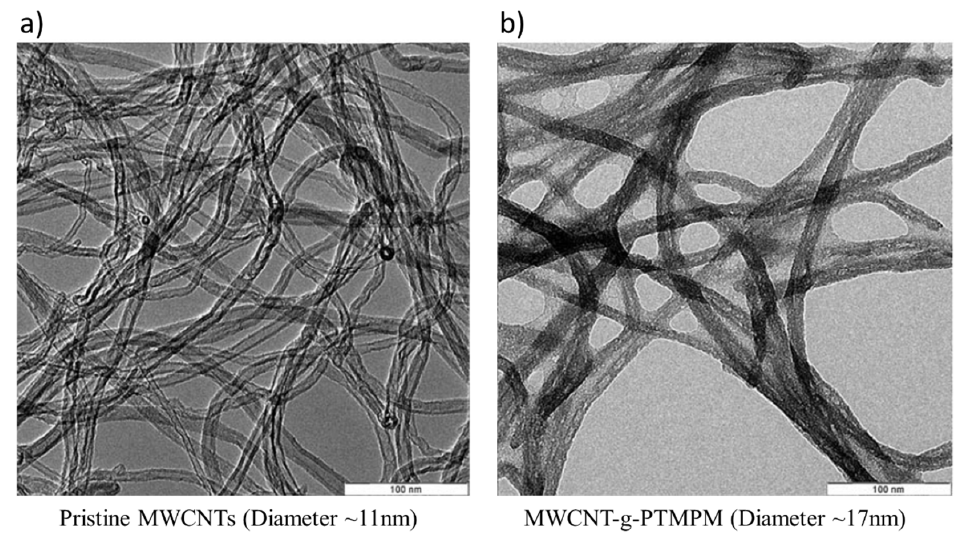
Figure 4. Transmission electron microscopy (TEM) micrographs of ( a ) pristine MWCNTs and ( b ) MWCNT-g-poly(2,2,6,6-tetramethyl-4-piperidyl methacrylate) (PTMPM) (MWCNT-g-PTMPM)—Scale bars: 100 nm (Republished with permission (2020) of the Royal Society of Chemistry from Ernould, B.; Devos, M.; Bourgeois, J.-P.; Rolland, J.; Vlad, A.; Gohy, J.-F. Grafting of a Redox Polymer